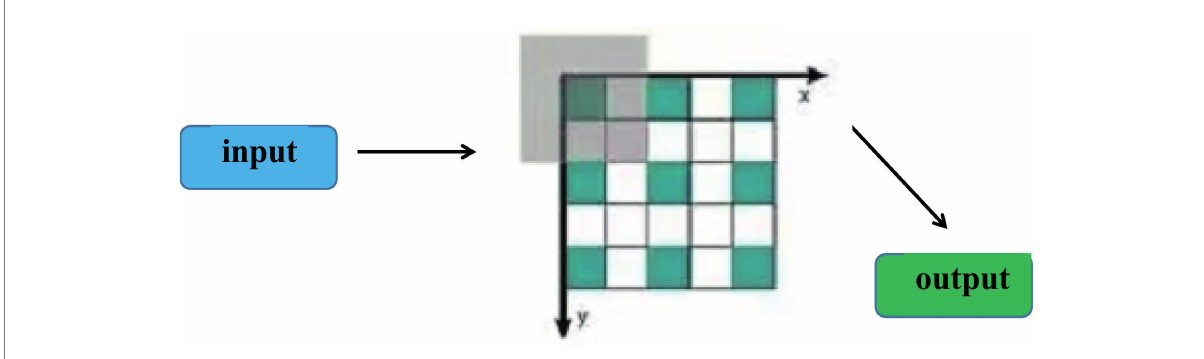
FIGURE 3 The application of ACNN in the dissemination of mental health